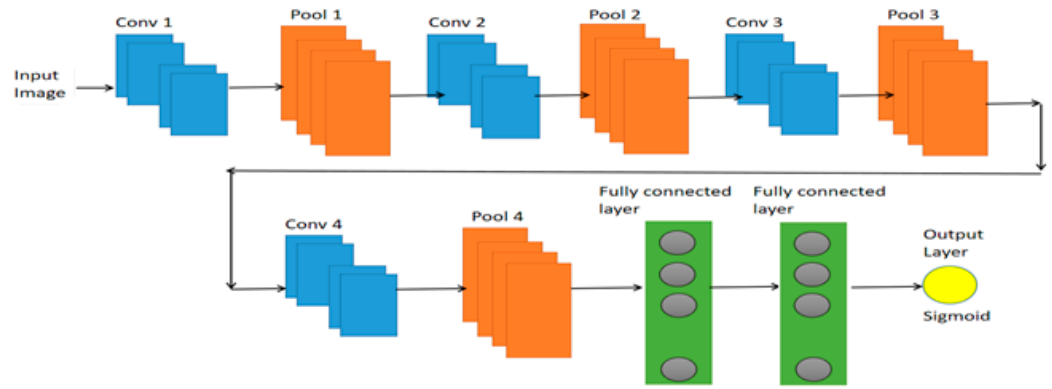
Figure 3. Convolutional Neural Network.